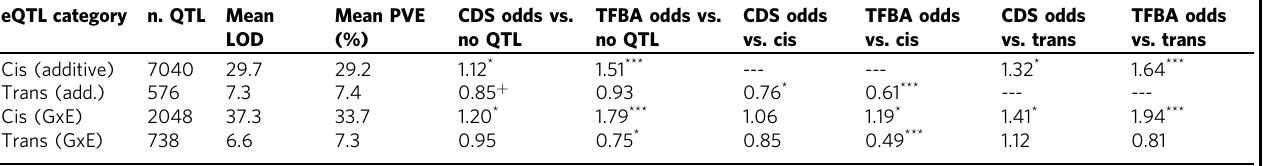
Table 2 Summary of cis- and trans-eQTL effects eQTL category n. QTL Mean